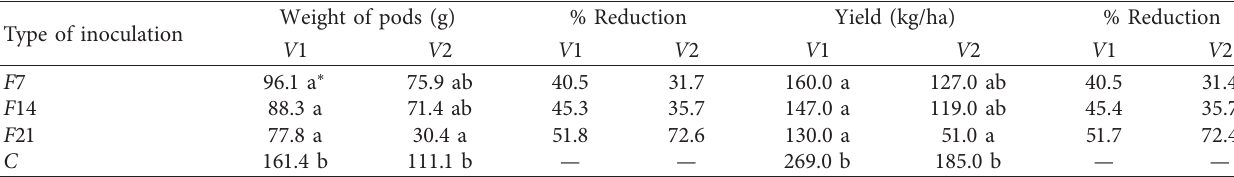
Figure 3: Healthy Essoumtem okra plants in potting bags (control) (a) and wilted clemson spineless plants in potting bags that received the treatment NF7 (b) and red arrows show some wilted plants. Table 7: Weight of pods and yield of “Essoumtem” and “Clemson spineless” inoculated serially with Fusarium oxysporum f sp. vasinfectum in field